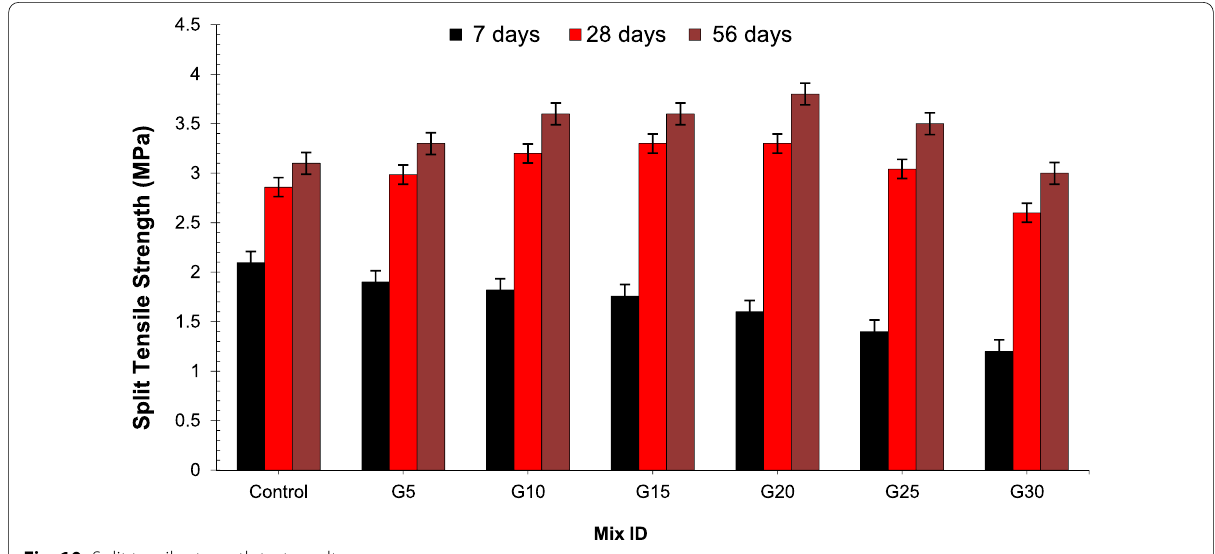
Fig. 10 Split tensile strength test results.